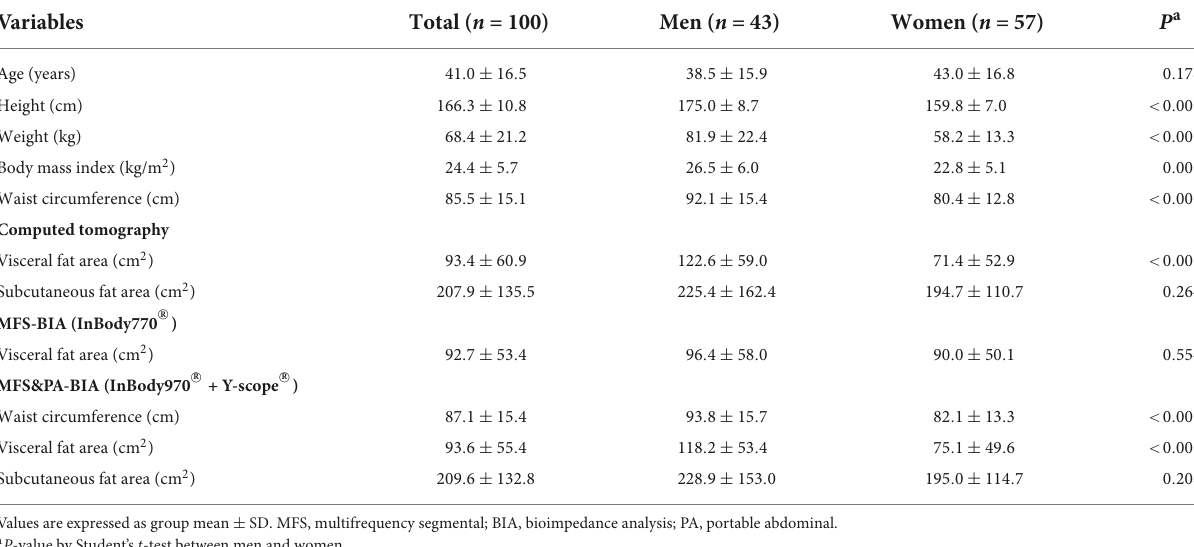
TABLE 1 Clinical characteristics of study subjects.